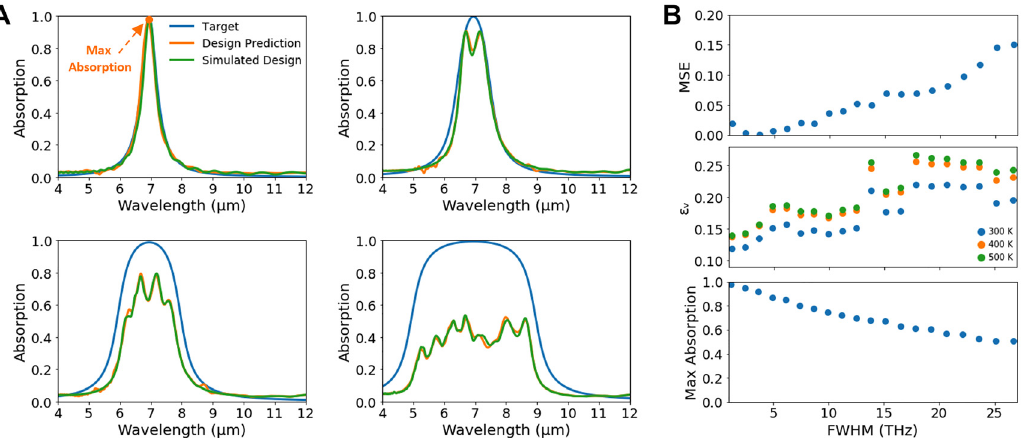
Figure 5: Probing metasurface design relations using the tandem network. (A) Tandem network input targets (blue lines) for various Lorentzian functions (FWHM of 0.6, 1, 2, and 3 µm centered at 7 µm) and the correspondingforwardnetwork-predictedresults(orangelines).Thenetworkisunabletoidentifydesignsthatexceedthemodel ’ sestimateof bandwidth/maximum absorption of the explored class of supercell metasurfaces. Full-wave simulation results are shown (green lines) for comparison, indicating that the network-predicted results match well with the ground truth. (B) Network-determined design trends and metrics,includingthemean-squarederror (MSE)betweentargetanddesignresponses,emissivityofthemetasurface,andmaxabsorptionas functions of FWHM